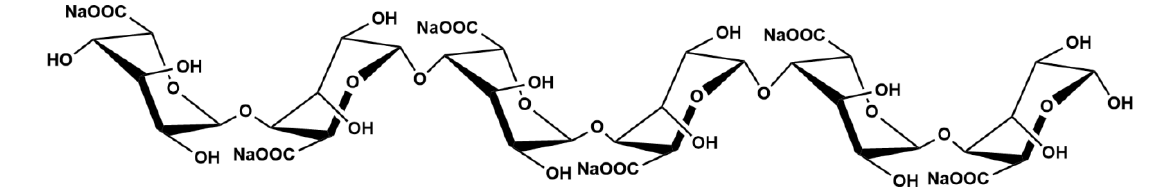
Figure 1. Chemical structure of α- L -Hexaguluroic acid hexasodium salt (G6).